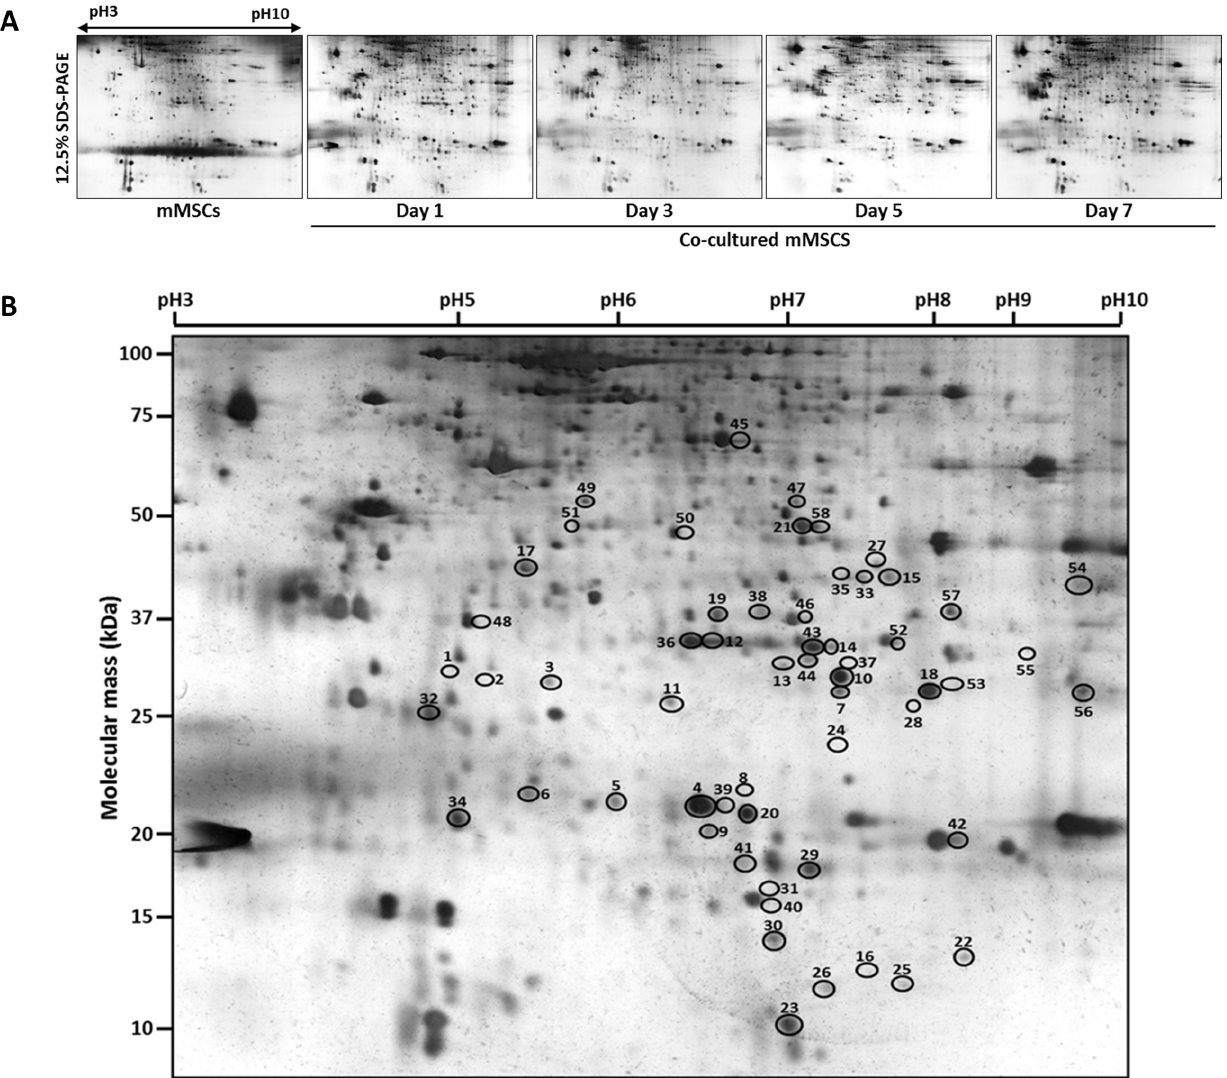
Figure 3. Two-dimensional gel electrophoresis images and spot analysis revealed 58 differentially expressed proteins. A) Following the co-culture of mMSCs with pSGCs for 1, 3, 5 and 7 days, total cell lysates (200 m g) were separated on pH 3–10 linear IPG strips in the first dimension and 12.5% SDS-PAGE in the second dimension. The gels were stained with mass spectrophotometry-compatible silver staining kit. B) According to the data analyses, expression levels of 58 spots (circled) were significantly altered at least by 1.5 fold (p , 0.05, one-way ANOVA with Bonferroni post-hoc test). Each of these spots has a specific spot number for database storage and further analysis. Data from five independent experiments (Five gels in duplicate for each time point) were analyzed and the gel figure presented here is from day